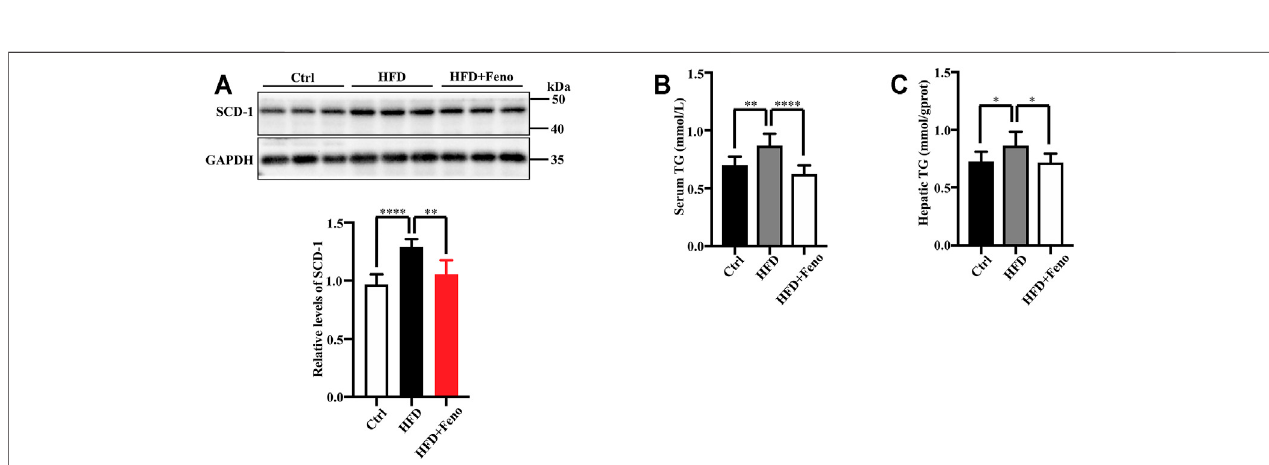
FIGURE2| Feno fi brateattenuateslipidaccumulationinHFD-fedmice. (A) ThelevelsofSCD-1weremeasuredbywesternblottingafter14 weeks.Representative western blots are shown. These results are means ± SD ( n (cid:1) 5 – 8 mice/group). ** p < 0.01, **** p < 0.0001, HFD group versus control group, or feno fi brate + HFD-fed group versus HFD group. (B) Serum triglyceride (TG) levels and (C) hepatic TG levels. These results are means ± SD ( n (cid:1) 10). * p < 0.05, ** p < 0.01, **** p < 0.0001, HFD group versus control group, or feno fi brate + HFD-fed group versus HFD group.